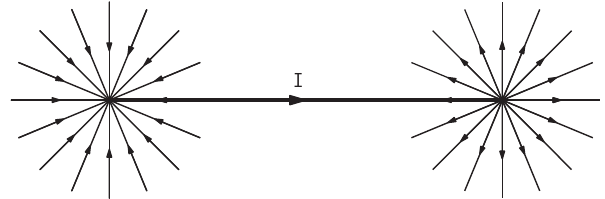
Fig. 2. Ionospheric current system equivalent to that in Fig. 1. The current is viewed